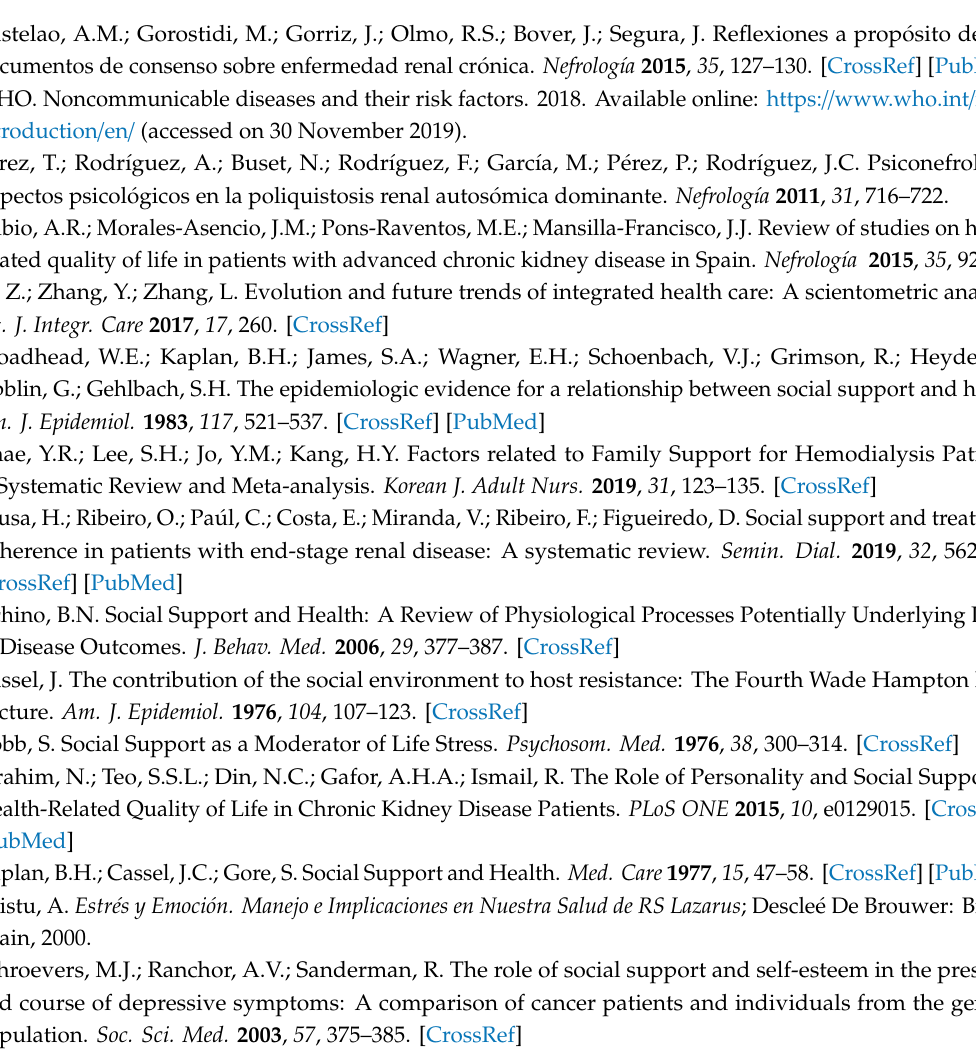
Table S1: Relationship between the physical limitations dimension of the KDQOL-SF TM instrument and the social support dimensions of the MOS survey., Table S2: Relationship between the emotional limitation dimensions of the KDQOL-SF TM instrument and the social support dimensions of the MOS survey., Table S3: Correlation between the physical and mental component of the SF-36, emotional support, instrumental support, a ff ective support, cognitive function, sexual function, problems and symptoms, discomforting e ff ects of the kidney disease, the burden of the kidney disease and social